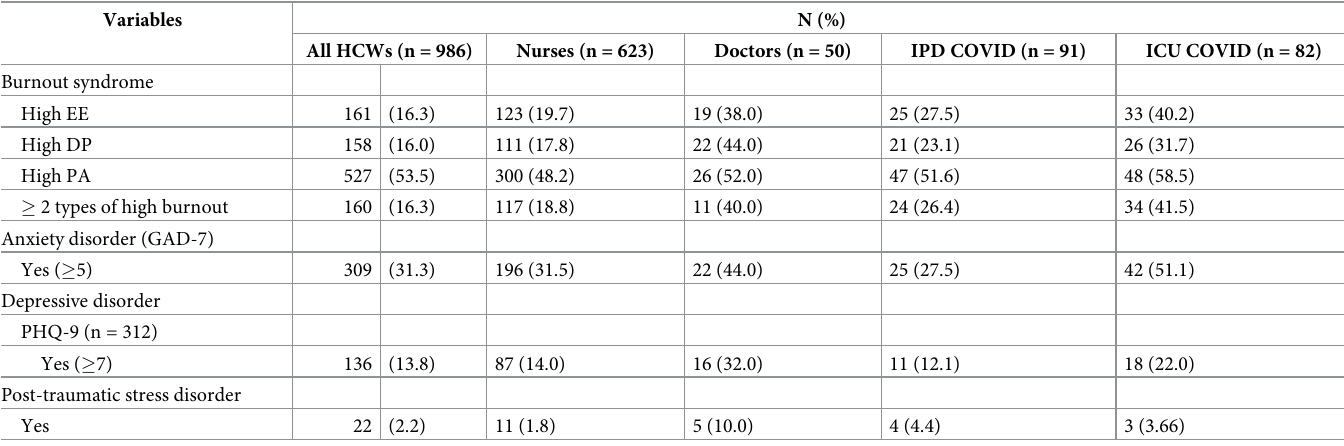
Table 2. Prevalence of burnout and mental health